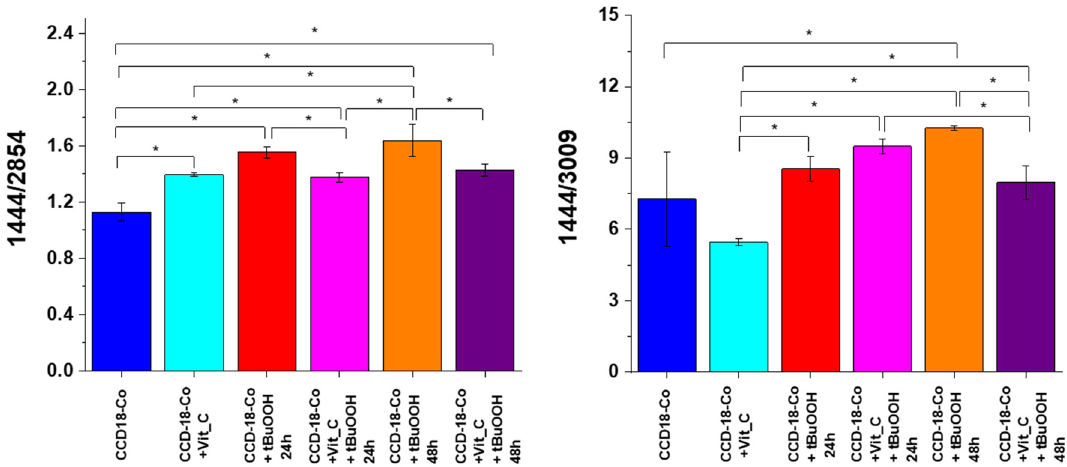
Figure 12. Raman band intensities ratios for selected Raman bands corresponding to lipids for six groups of normal human colon cells CCD-18 Co: control group (labeled CCD-18 Co, blue), group supplemented with vitamin C (labeled CCD-18 Co+Vit_C, turquoise), group supplemented with tBuOOH for 24 h (labelled CCD-18 Co + tBuOOH, 24 h, red), group supplemented with vitamin C and tBuOOH for 24 h (labelled CCD-18 Co+Vit C + tBuOOH, 24 h, magenta), group supplemented with tBuOOH for 48 h (labelled CCD-18 Co + tBuOOH, 48 h, orange), group supplemented with vitamin C and tBuOOH for 48 h (labelled CCD-18 Co +Vit C + tBuOOH, 48 h, violet). As shown in Figure 12, it also affects the lipids’ presence in cells of the human colon; the statistically significant results, based on ANOVA analysis, have been marked with